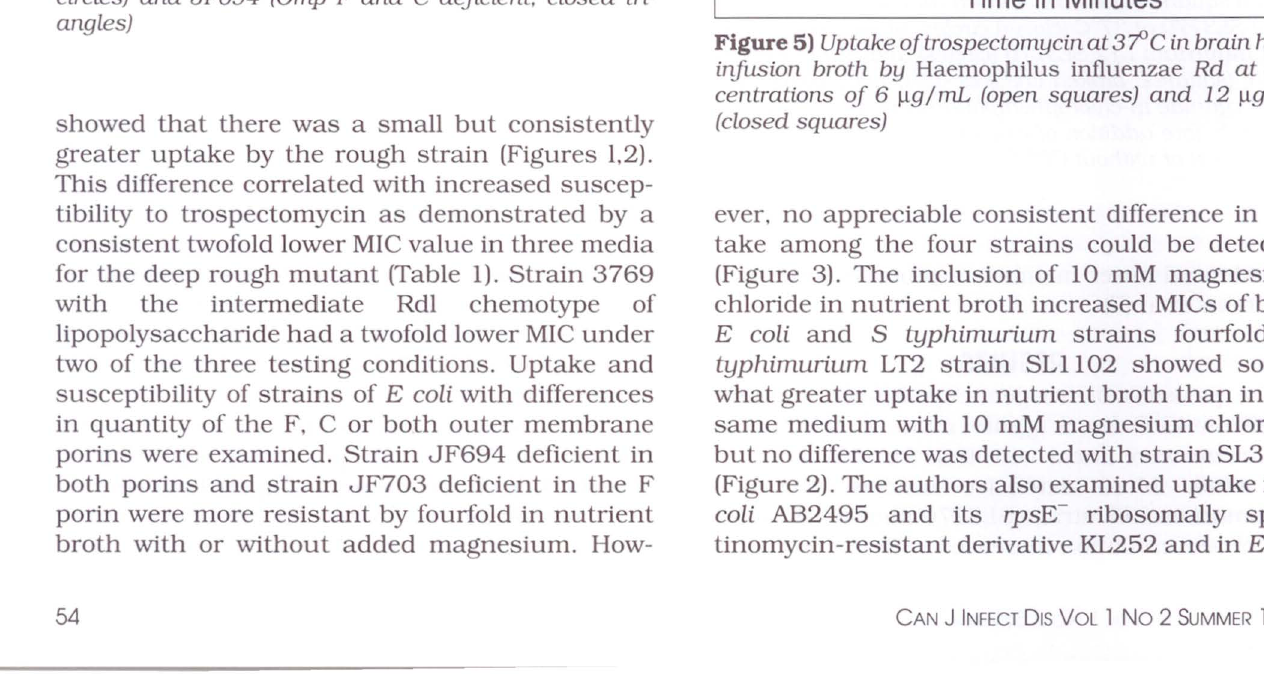
Figure 5) Uptake of trospectomycin at 3 'f1 C in brain heart infusion broth by Haemophilus influenzae Rd at con centrations of 6 119/ mL (open squares) and 12 119/mL (closed squares)